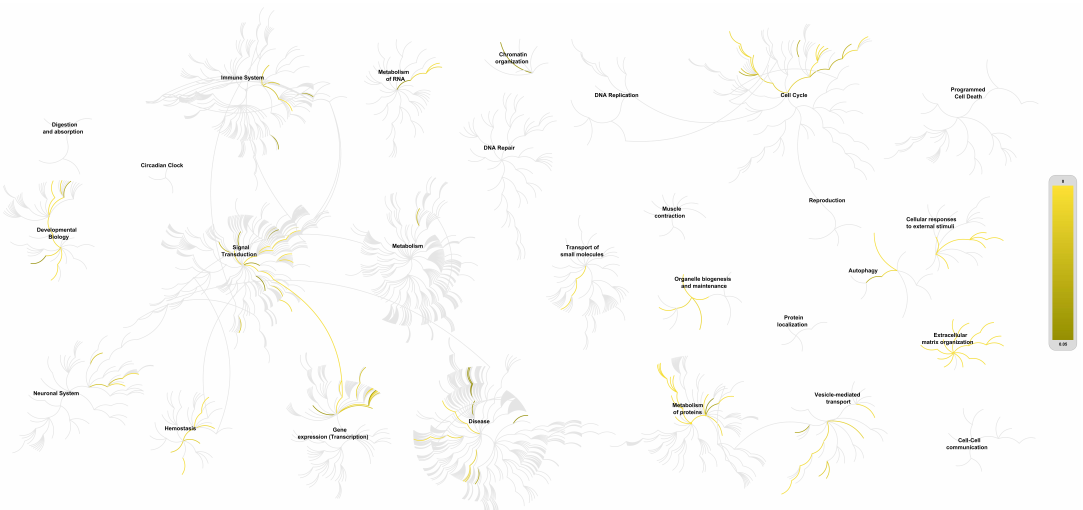
Figure 6. Enrichment analyses of the interactome of the lysyl oxidase family using Reactome. The center of each of the circular “bursts” is the root of one top-level pathway (e.g., “Extracellular matrix organization”, “Metabolism of proteins”, “Cellular Response to external stimuli”, and “Signal transduction”). Over-representation of pathways are color-coded. Pathways which are not significantly over-represented are in light grey. The node size is related to the number of entities inside a